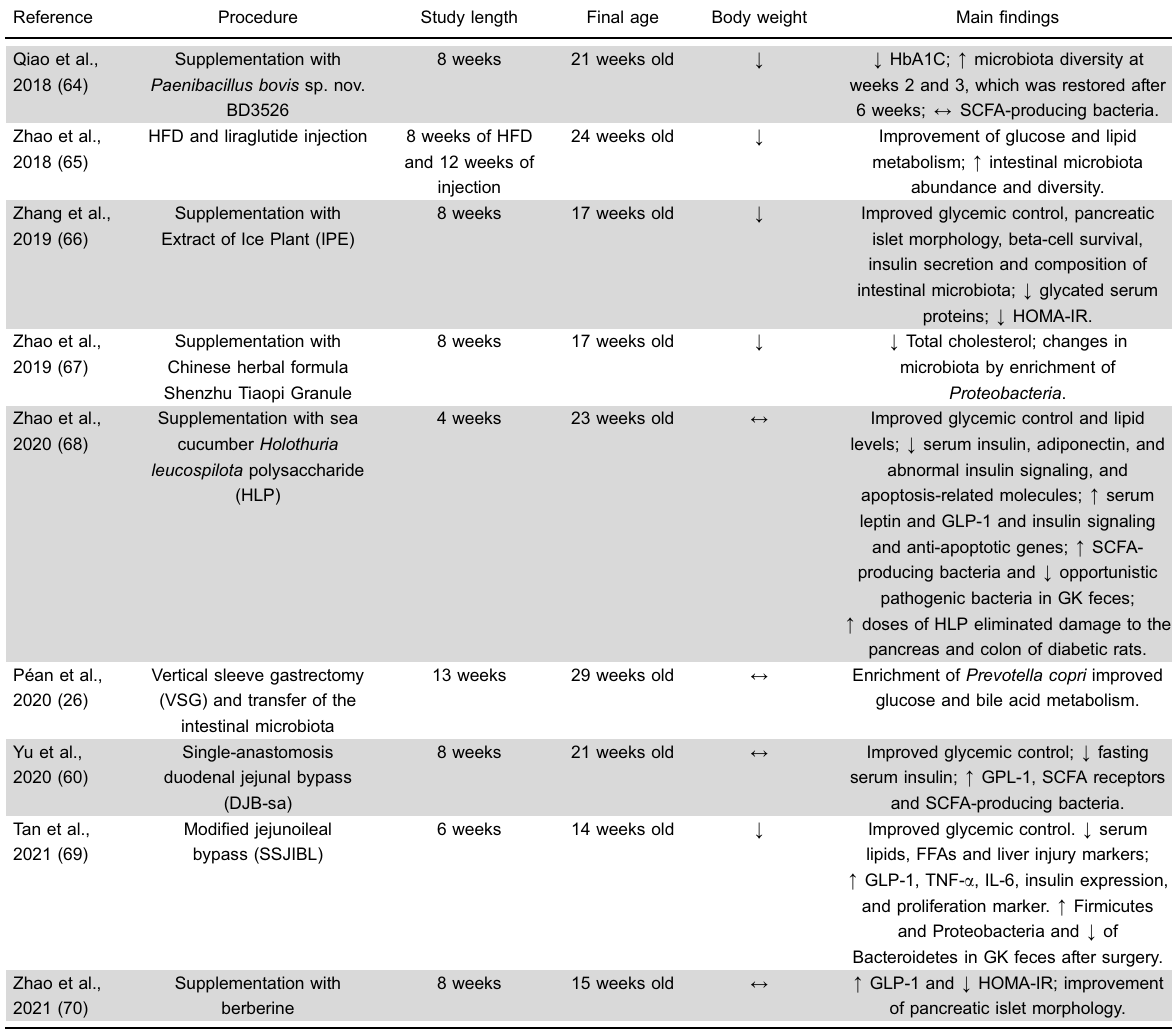
Table 1. Studies on interventions in the intestinal microbiota of Goto-Kakizaki (GK)